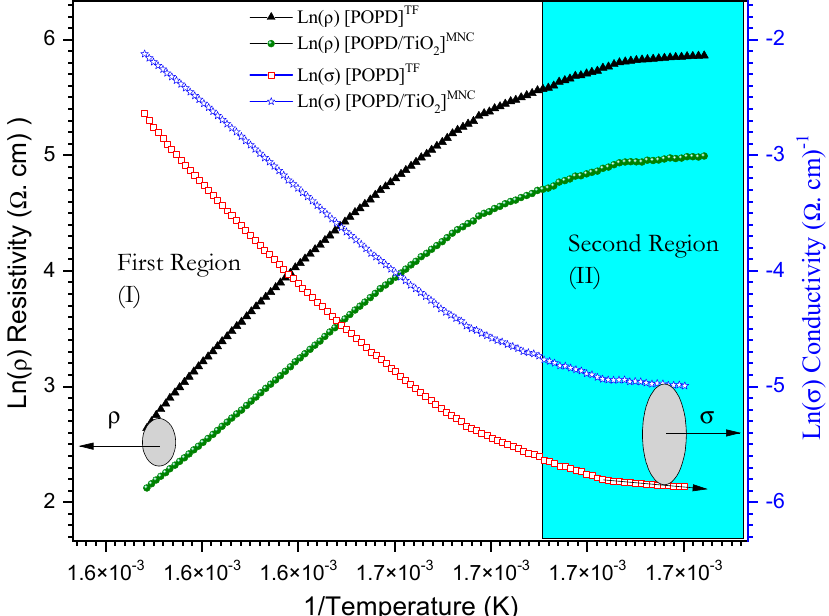
Figure 16. The dependence of DC resistivity and conductivity of [PoPDA] TF and [PoPDA/TiO 2 ] MNC thin films on temperature (1/T).